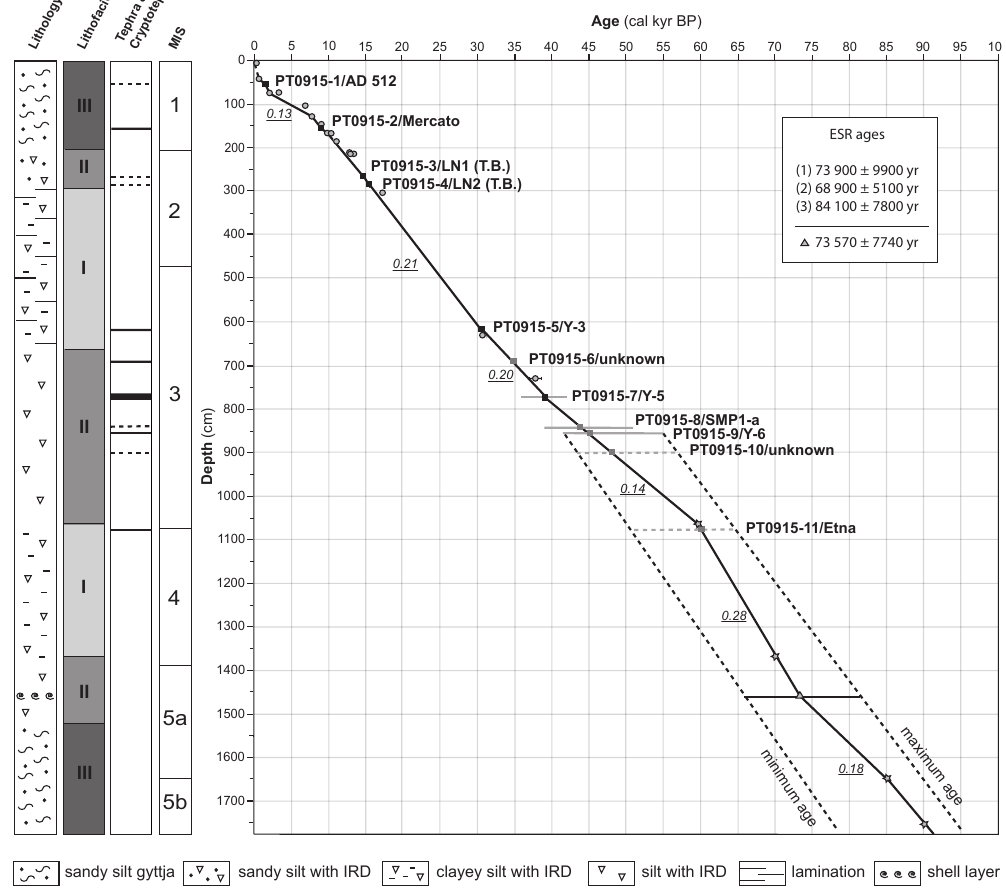
Fig. 10. Age-depth model and calculated sedimentation rates (mmyr − 1 ) for the composite core Co1215 from Lake Prespa. Lithology, lithofacies, tephras and cryptotephras, marine isotope stages (MIS) 1–5 (Bassinot et al., 1994) are also shown. The age-depth model is based on tephrostratigraphy (black and grey squares), radiocarbon dates (grey circles), an error-weighted mean ESR age of a shell layer at 14.58– 14.63m depth (grey triangle), and tie points resulting from the correlation with the oxygen isotope dataset from NGRIP-GICC05 (grey stars) (Fig. 2). Chronological tie points were interpolated on a linear basis, whereby dotted black lines indicate maximum and minimum ages. Grey lines show literature age-ranges proposed for tephras and cryptoptephras, whereas dotted grey lines and grey squares represent age-ranges and ages developed within the presented age-depth model for tephras and